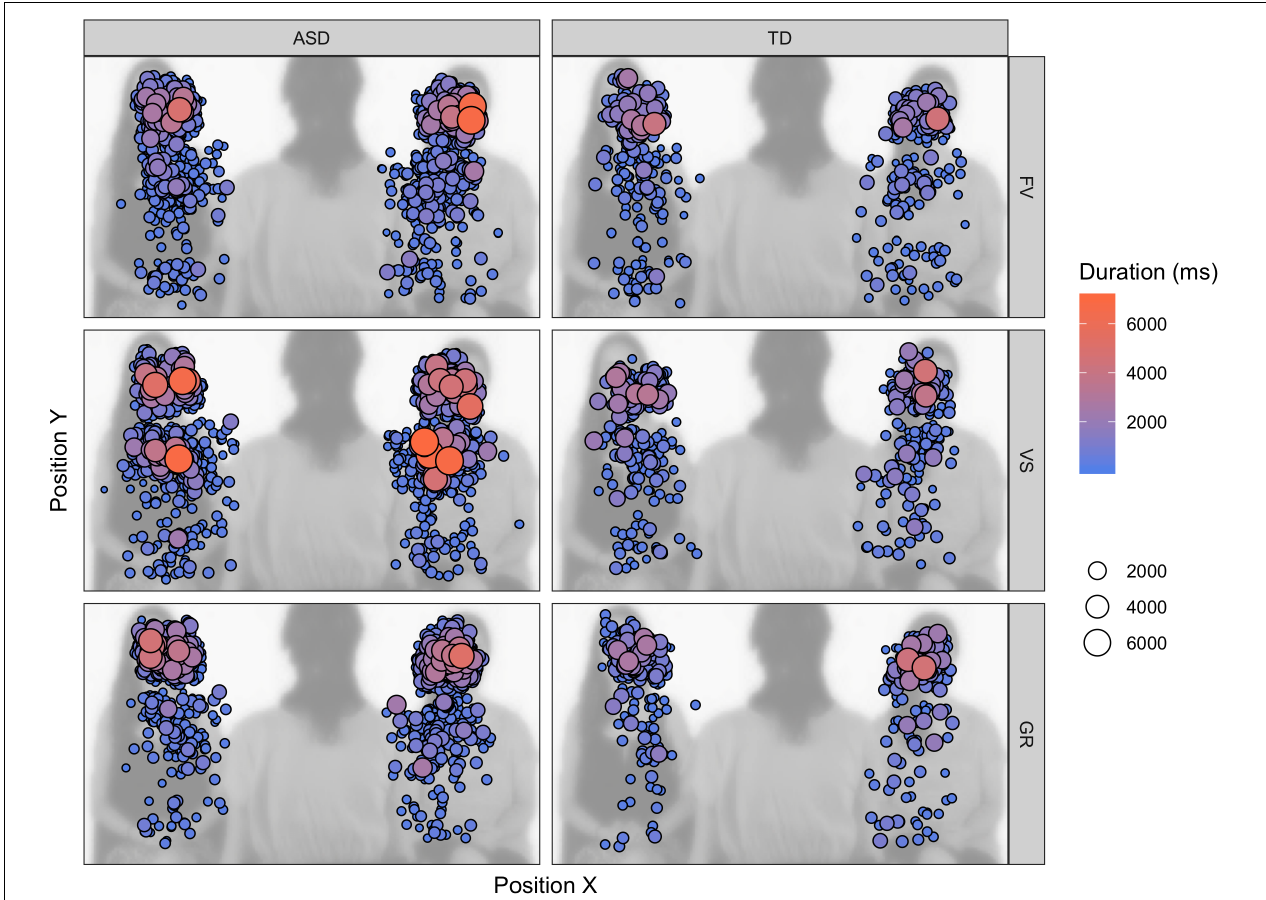
FIGURE 6 | Fixation map on the task-relevant AOIs (faces, bodies) across the experiment, superimposed on one of the video frames. The size and color of the fixation indicate the duration of the individual